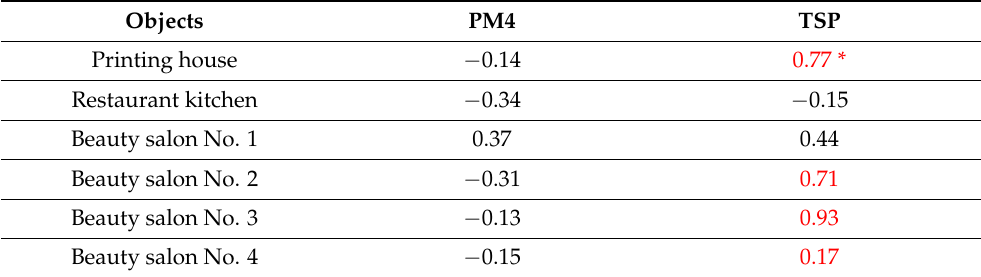
Table 3. Pearson’s linear correlation coefficients ( p = 0.05) dependence of 8 h PM concentrations in indoor air on 8 h PM concentrations in atmospheric air, for six tested objects in Bytom, in the period from 26 September to 31 October